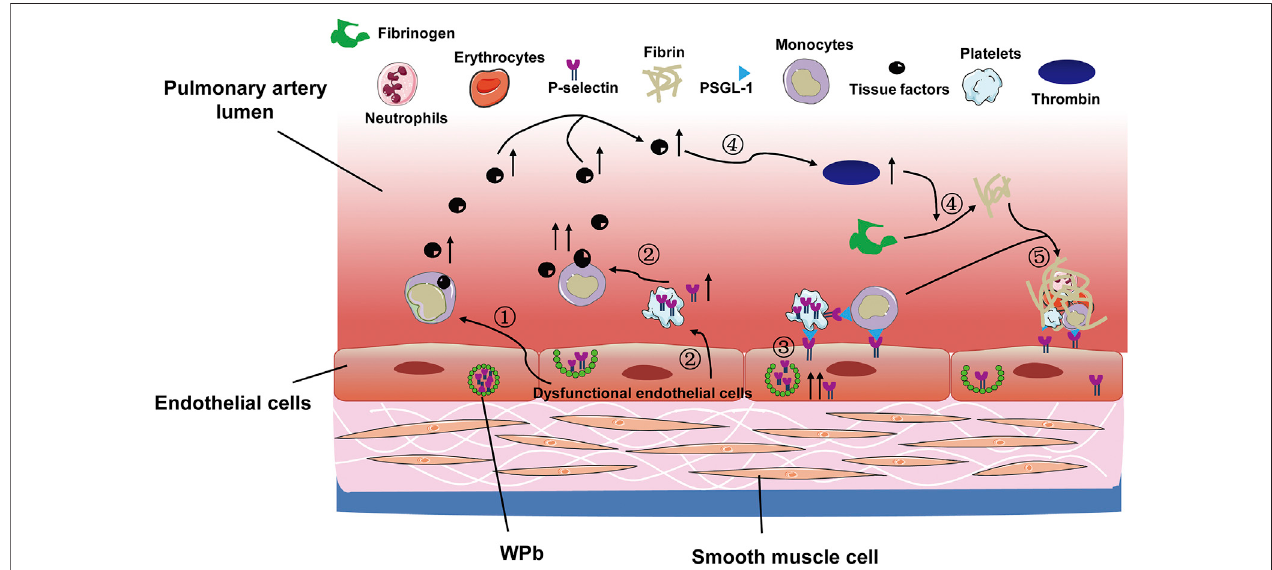
FIGURE 3 | The coagulation cascade activated following pulmonary vascular endothelial cell injury. The pulmonary vascular hypoxic and in fl ammatory scenario leads to the following events: 1) endothelial cell injury and upregulates TF expression on monocytes; 2) the injuried endothelial cells promote platelets to release P-selectin,whichfurtherincreasesTFproduction; 3)theendothelial cellspersereleaseP-selectin,whichadheres toplateletsandleukocytes, facilitatingtheirdeposition onto the endothelia; 4) the increased production of TF enhances thrombin production, which promotes conversion of fi brinogen to fi brin; 5) the deposited leukocytes and platelets are entangled with fi brin, leading to in situ pulmonary thrombosis. TF, tissue factor; WPb, Weibel-Palade bodies; PSGL-1, P-selectin glycoprotein ligand 1.